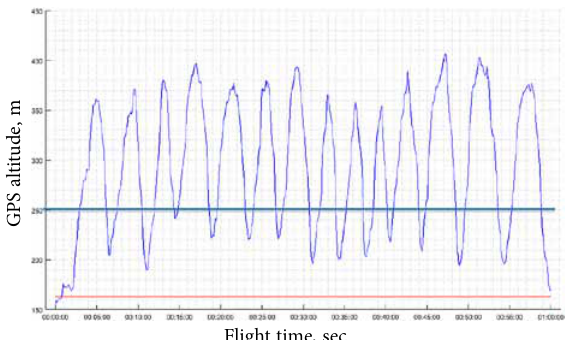
Fig. 14. Altitude of fourteen flight circuits Instead of duration, the axis may laso indicate flight distance. Several distance measurement variants are pos- sible. The Great Circle route distance may be calculated using geographical coordinates from point A (φ point B (φ , λ ) by adding the distances using equation (3): 2 2